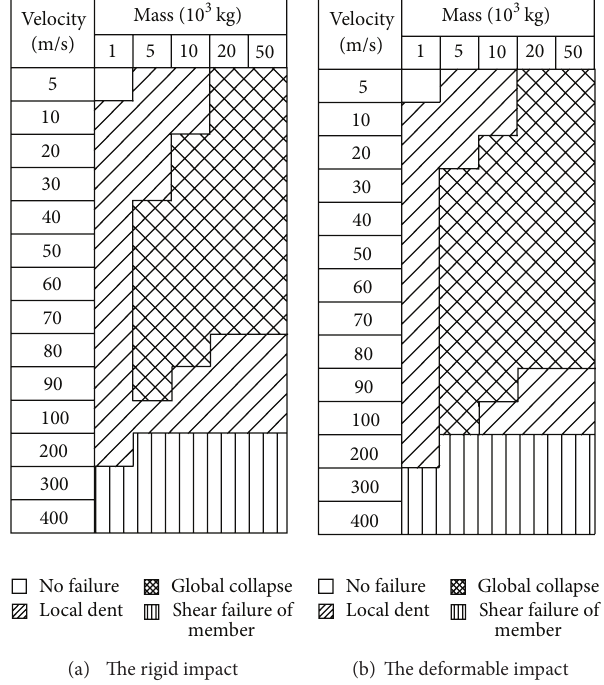
Figure 10: Comparison of the impact events with the roof load of 120 kg/m 2 between the rigid impact and the deformable